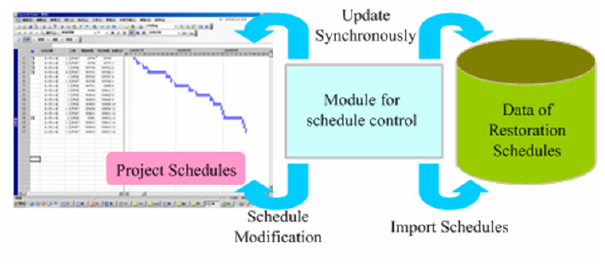
Fig. 7. Synchronous schedule maintenance